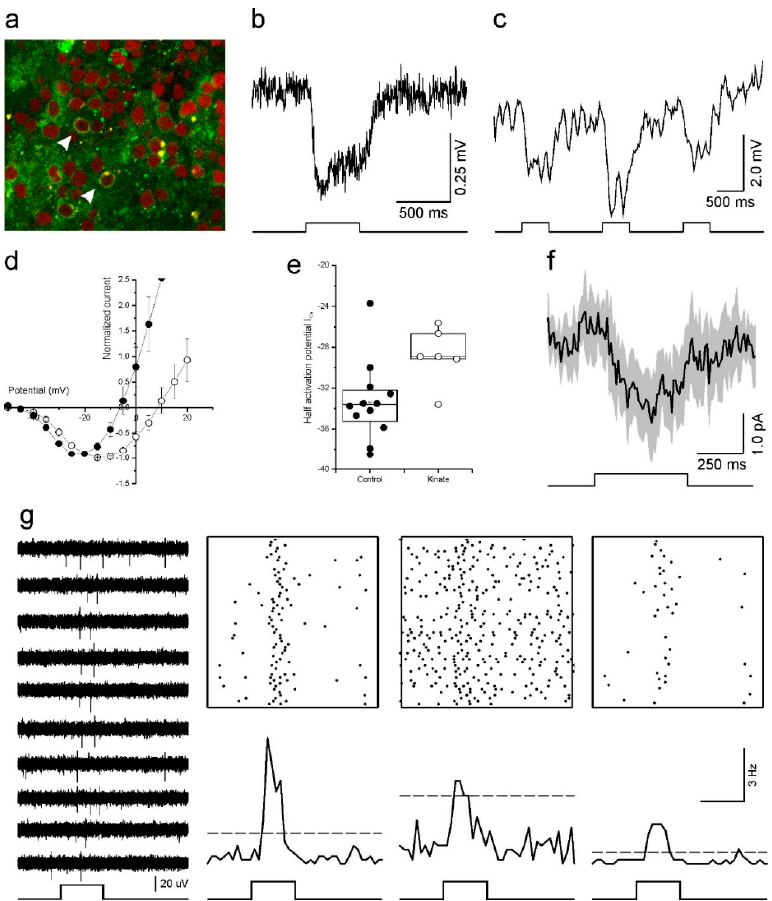
Figure 5. Optogenetic reactivation of cultured human retinas. ( a ) Fluorescent image of a transfected retina. Arrowheads indicate transfected cones with eNpHR-EYFP in their membrane (green). The red label is a nuclear stain (ethidium bromide). ( b ) The light response of an optogenetically reactivated cone to a full-field light-flash stimulus. The restored response begins soon after the onset of the 500 ms light stimulus (bottom) and remains for the duration of the flash. ( c ) An optogenetically reactivated cone’s light response to 500 ms flashes of blue (465 nm), green (525 nm) and red (624 nm) LED light. The flash of green light elicited the largest hyperpolarizing response. ( d , e ) Depolarizing horizontal cells with kainic acid shifted the cone I Ca voltage dependency to more positive potentials as demonstrated by the mean ( ± SEM) leak subtracted and normalized IV-relations ( d ) and I Ca half activation potential ( e ) for cones in control conditions (closed circles, n = 12) and for cones treated with 30 µ M kainic acid (open circles, n = 6). ( f ) The light-induced horizontal cell feedback signal measured in cones (mean ± SEM, n = 7). The feedback signal is evident by the inward current deflection occurring in conjunction with the full-field light flash. ( g ) Multi-electrode array recordings of light induced ganglion cell responses from a retina with optogenetically reactivated cones. Representative traces of extracellular potentials from one electrode to a repeated 500 ms full-field light flash stimulus are shown on the left. The upper right panels show Rasta plots of spiking activity occurring on three electrodes during one hundred repetitions of the full-field light flash stimulus. The same data is redrawn as peristimulus time histograms (50 ms bin widths) in the lower right panels, where the dashed lines indicate the mean + 5 standard deviations firing rate that occurred prior to the flash onset. In both representations increased ganglion cell firing coincides with the light